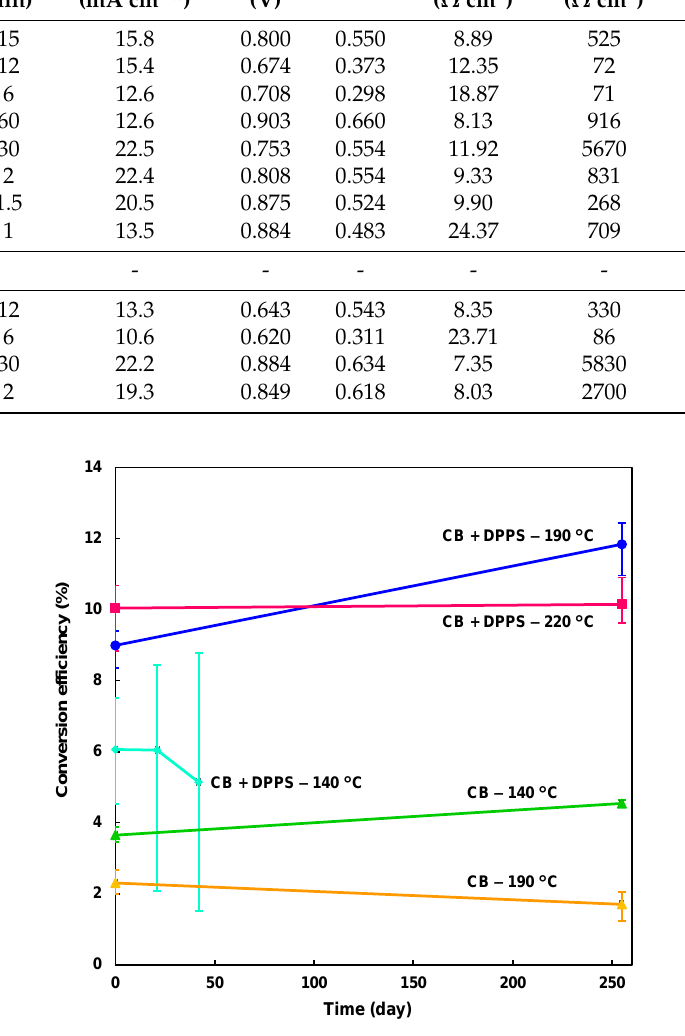
Figure 3. Stabilities of the present devices.